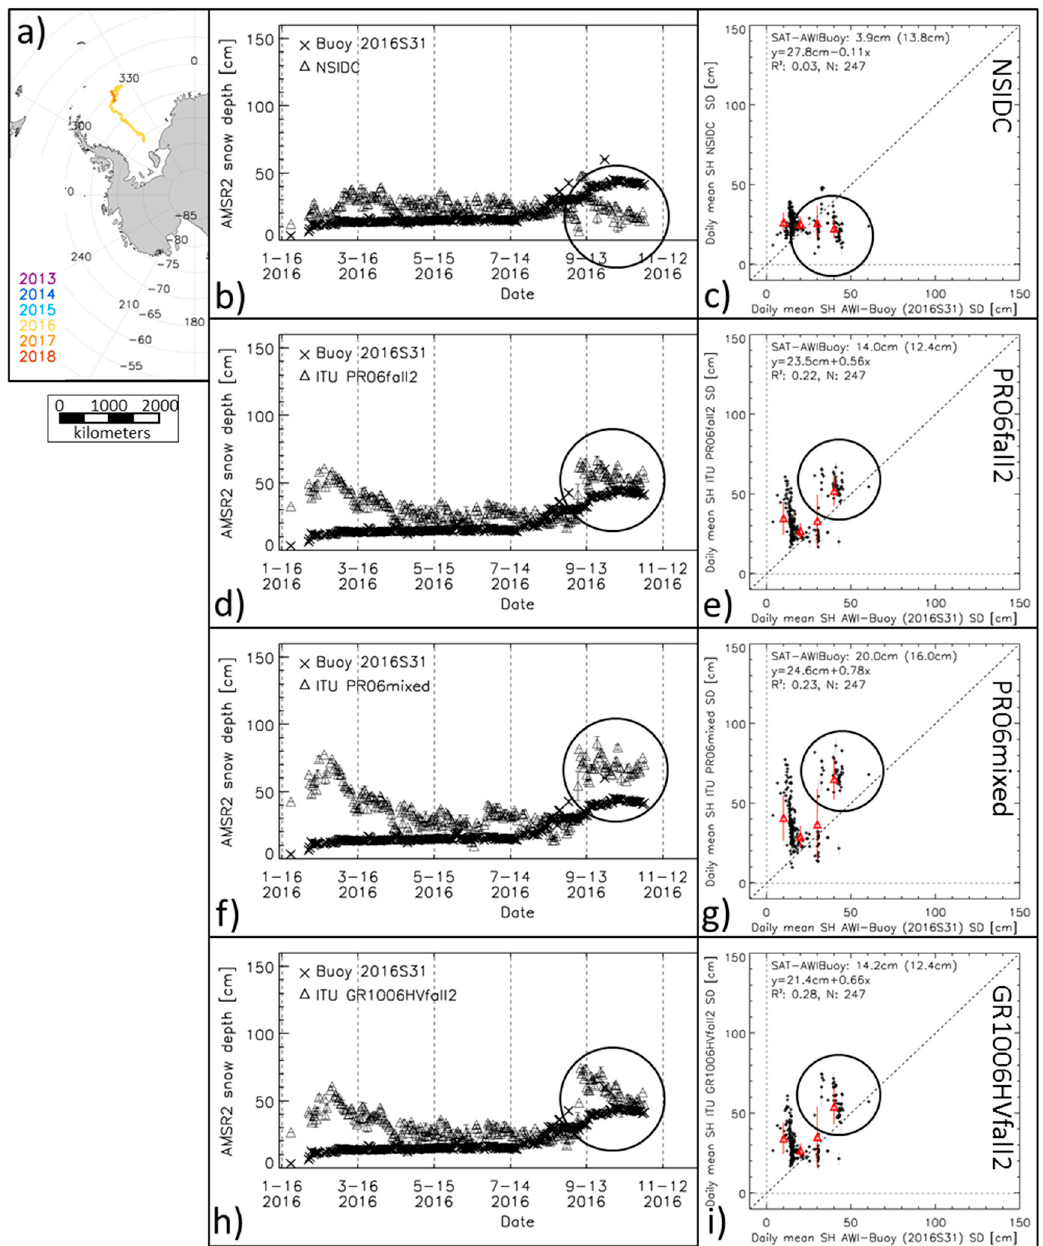
Figure 13. The results of the comparison between the AMSR2 snow depth and the snow depth observed by AWI buoy 2016S31. Panel ( a ) shows a map showing the track of the buoy color-coded according to the year of operation; panels ( b , d , f , h ) show the time series of the buoy (crosses) and NSIDC (triangles) snow depth; panels ( c , e , g , i ) show the scatterplots of the data shown in the time series. For colors and parameters given in the scatterplots, see the caption of Figure